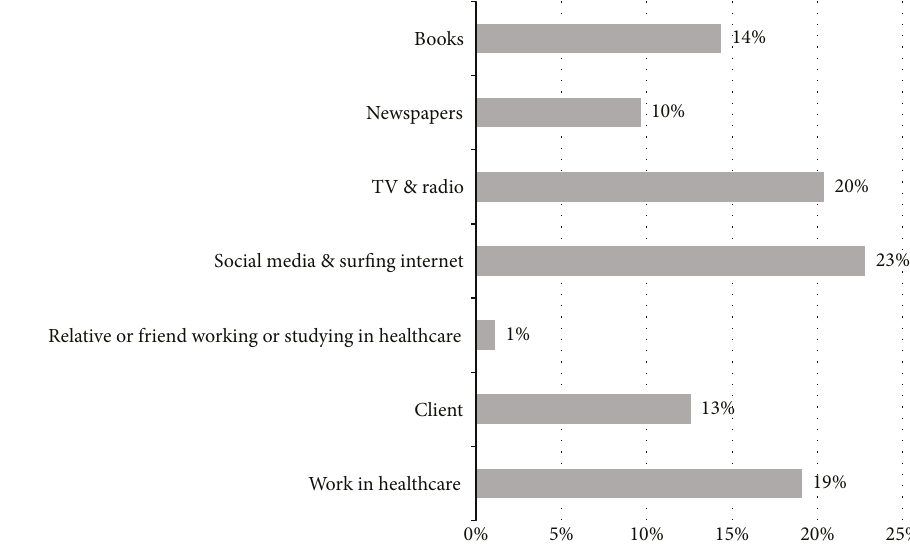
Figure 2: Sources of knowledge and awareness of OT.